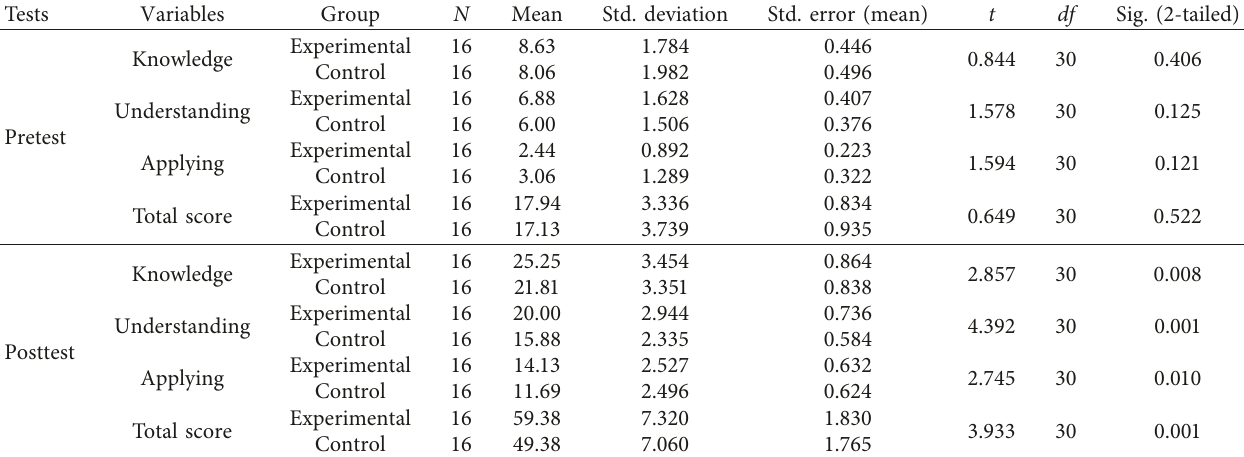
Table 5: Independent sample t -test for pre- and posttest of average-achiever